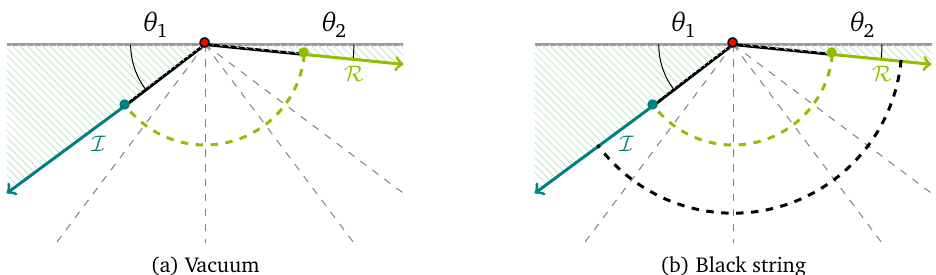
Figure 1: (a) Embedding of a KR braneworld with two subcritical branes in anti-de Sitter space. We refer to the left brane as the “physical" brane, and the right brane as the “bath" brane. R denotes the radiation region whose entanglement entropy we wish to calculate, and the dashed green line connected to the boundary of R is the candidate RT surface. I is the entanglement island on the brane corresponding to the RT surface in green. (b) Embedding of a KR braneworld with the same tensions in the black string geometry. The dashed black line is the black string horizon separating the exterior and interior